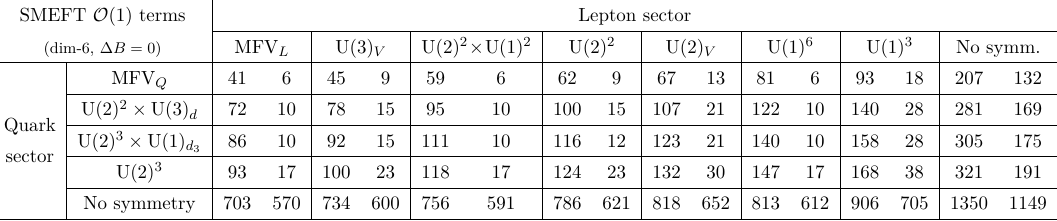
Table 1 . Overview of the number of independent O (1) terms for the dimension-6 SMEFT operators ( ∆ B = 0 ) for different assignments of quark and lepton symmetries considered in the paper. The left (right) entry in each column gives the number of CP even (odd) coefficients for each symmetry